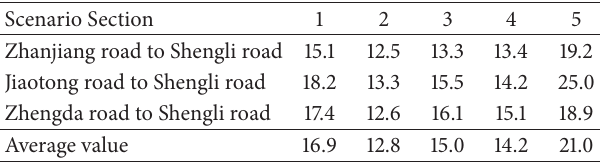
Table 5: Car delays (s) in five scenarios along Eastbound Shengli road.